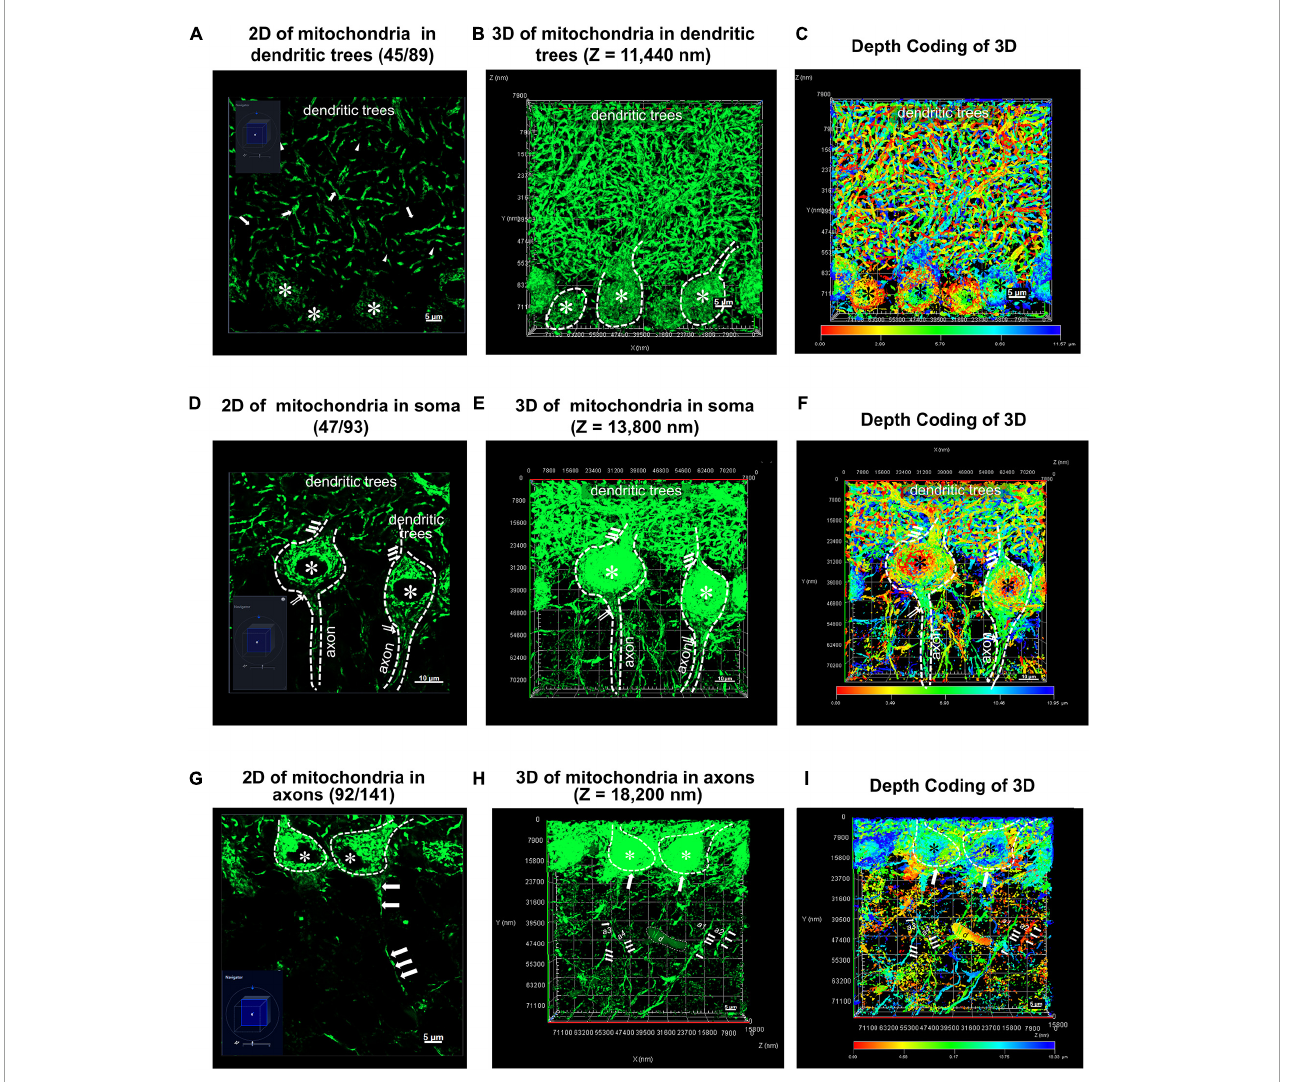
FIGURE3 Two and three dimensional (2D and 3D) images acquisition of mitochondrial network within Purkinje cells from PCs-Mito-GFP mice. (A,D,G) A typical two dimensional (2D) image under light microscope (LM) for mitochondrial network within dentritic trees (A) , soma (D) and axons (G) of cerebellar Purkinje cells (PCs) from a PCs-Mito-GFP mouse. The navigation diagram in the bottom left corner indicates the exact position of image. Soma of PCs are indicated by asterisk ( ∗ ) and one long axon indicated by a series of arrows. (B,E,H) A three dimensional (3D) image with z stack of 11,440 nm (B) , 13,800 nm (E) and 18,200 nm (H) is set up from 2D images of panels (A,D,G) , respectively. We find an unknown debris (d) in panel (H) . (C,F,I) A 3D image is set up under Depth Coding mode from 3D image in panels (B,E,H) . The Depth Coding diagram on the bottom indicates that the red dots lie on the superficial layer and the blue dots on the deep layer. The same debris (d) appearing in panel (H) is yellow color which suggests its location as bottom in the depth. Bars = 5 µ m in panels (A,G) , and Bars = 10 µ m in panel (D)